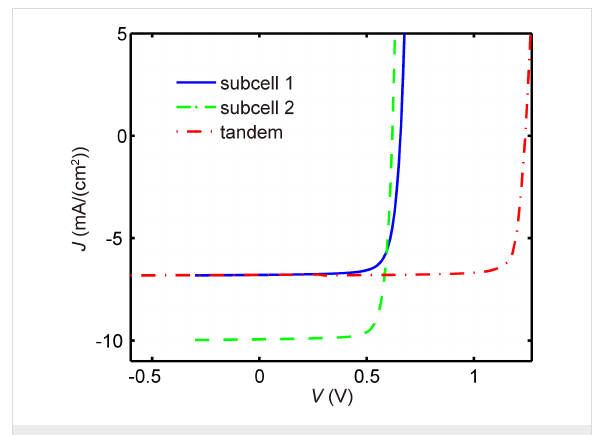
Figure 7: One example of a J – V curve for a tandem structure constructed from J – V curves of sub-cells. Sub-cell 1 is based on P3HT/PCBM, while sub-cell 2 is based on